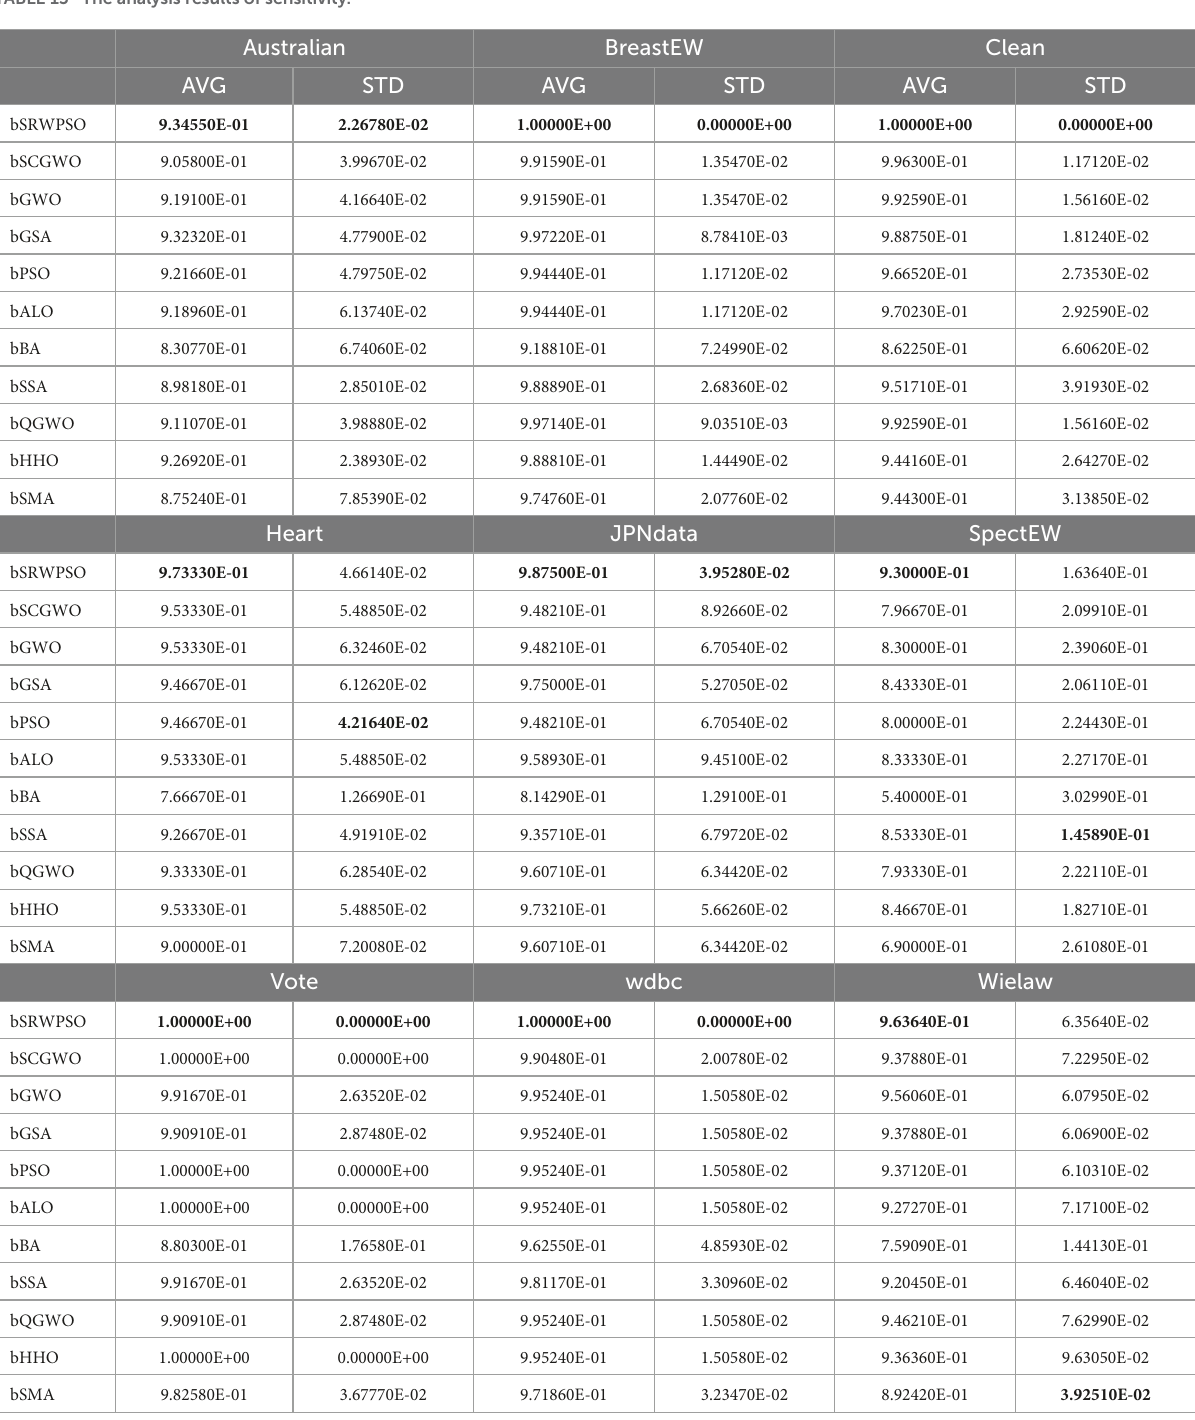
TABLE 15 The analysis results of